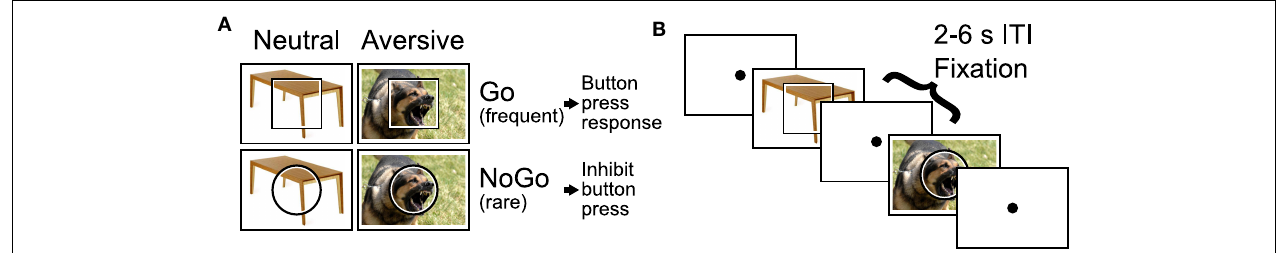
FIGURE 1 | Emotional Go/NoGo task. (A) Each trial was either a Go or NoGo trial and featured an emotionally neutral or aversive distractor picture. (B) Example segment of two trials with 2–6s fixation intertrial intervals (ITIs) interleaved.